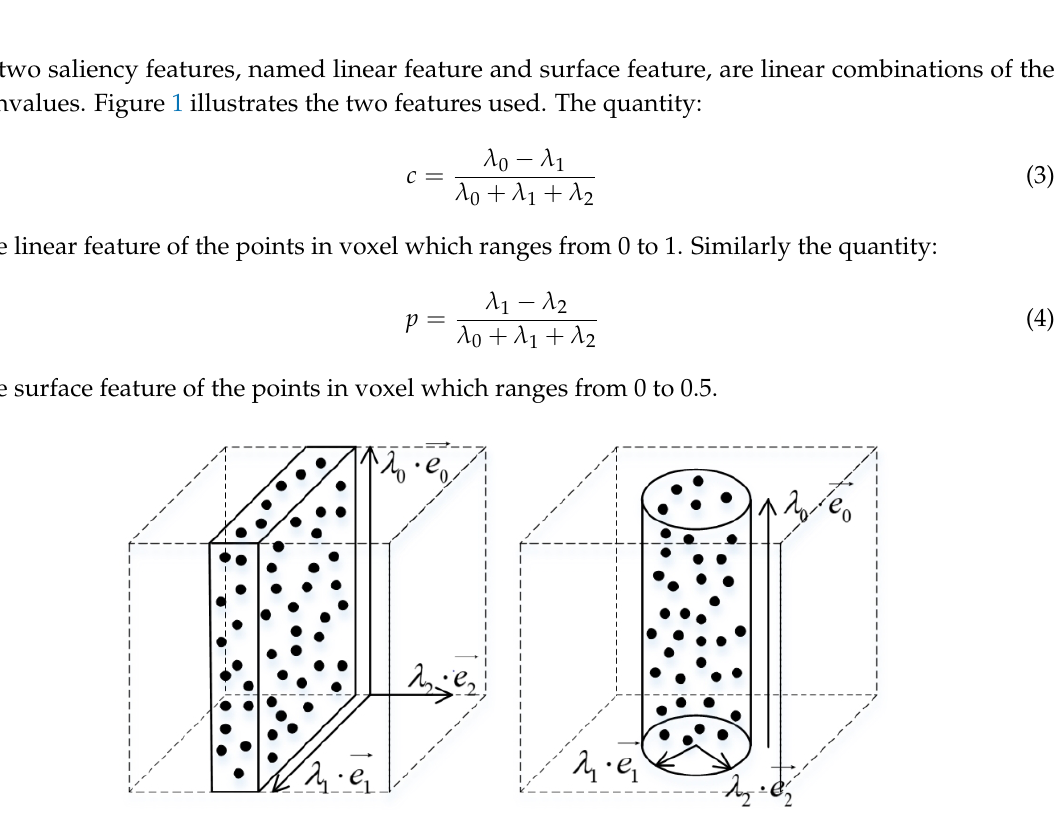
Figure 1. Illustration of the surface feature and linear